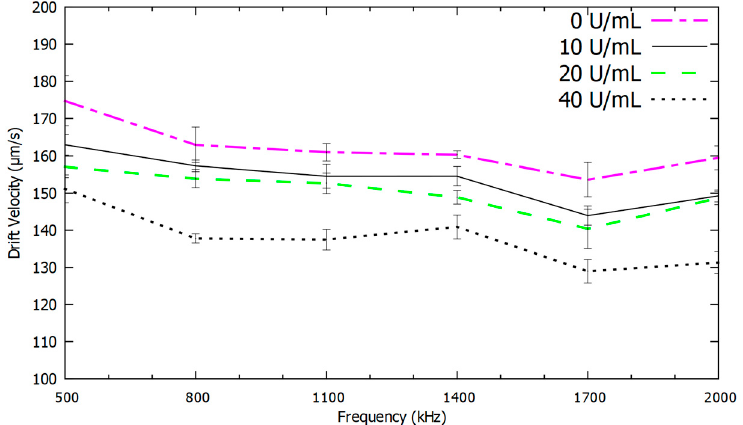
Figure 4. Negative DEP spectrum curves for cutoff levels of CA 242 for the detection of pancreatic cancer at 10 U/mL, 20 U/mL, 40 U/mL, and 0 U/mL. The 0 U/mL was a control sample without the native antigen of CA 242 in the sample to bind to CA 242-antibody functionalized PMs. The results shown in each frequency per curve are the mean of six measurements, and the error bars show their respective confidence intervals.